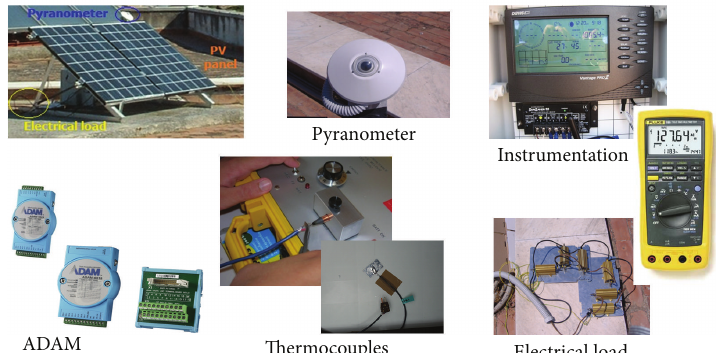
Figure 8: Experimental apparatus.